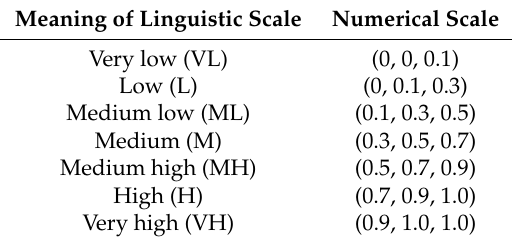
Table 1. Fuzzy numbers for the importance weight of each criterion.